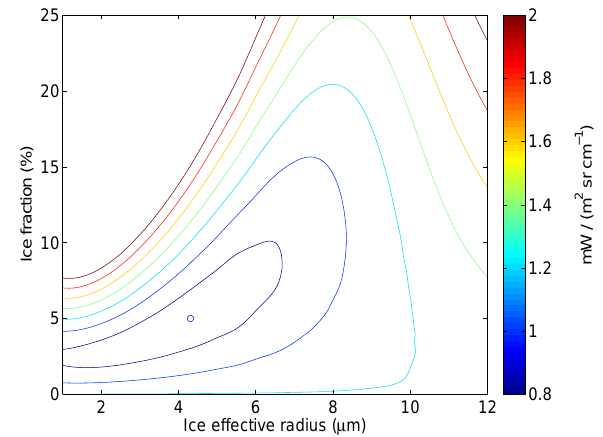
Fig. 5. Contours of the root mean square (rms) difference between simulated downwelling radiances from a look-up table and a model “measured” radiance, at selected frequencies (see text). Both mea- sured and simulated radiances are for a 240K cloud with a liq- uid water path of 8gm − 2 and liquid-droplet effective radius of 10µm − 2 . The measured radiance is for an ice fraction of zero and thus has no dependence on ice effective radius; it was created using liquid water refractive indices measured at 240K. Simulated radi- ances are for the ice effective radii and ice fractions given along the x and y axes and were created using liquid water refractive indices measured at 300K. The circle marks the minimum rms